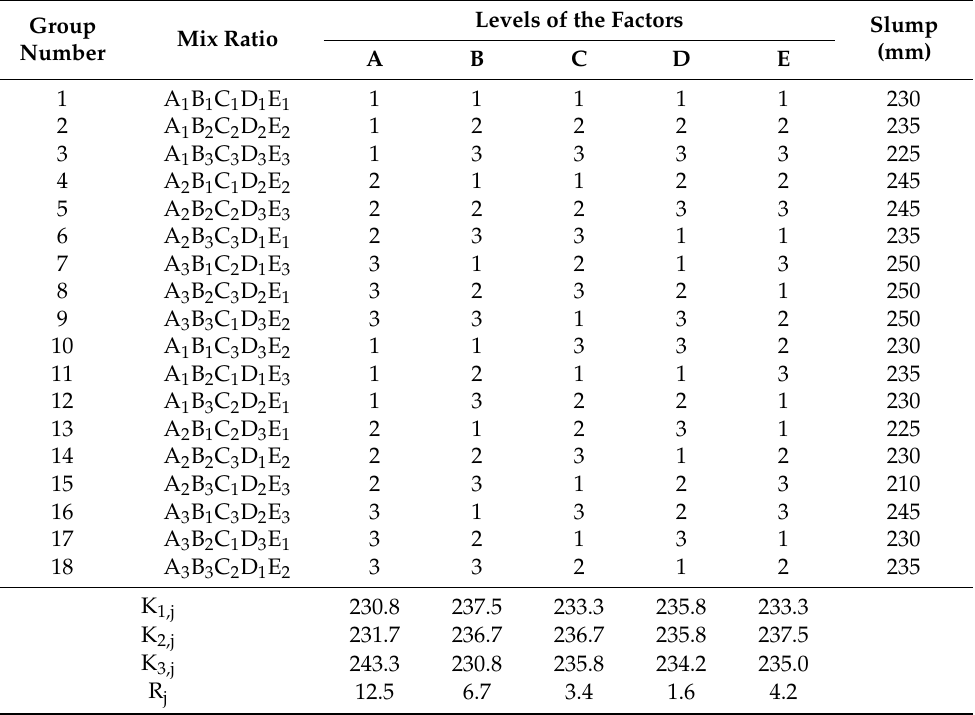
Table 15. Range analysis process based on the test results of slump.